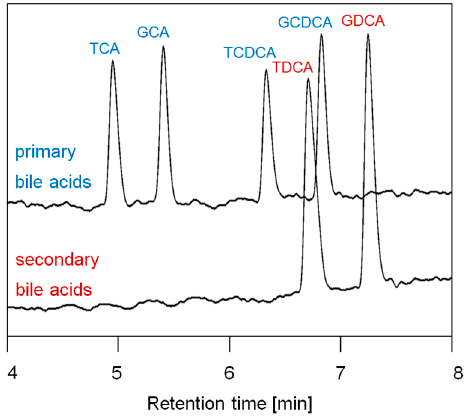
Figure 3. Separation of primary and secondary bile acids using HPLC-DAD at 200 nm (glycocholic acid (GCA), taurocholic acid (TCA), glycochenodesoxycholic acid (GCDCA), taurochenodesoxycholic acid (TCDCA), glycodesoxycholic acid (GDCA), taurodesoxycholic acid (TDCA)).